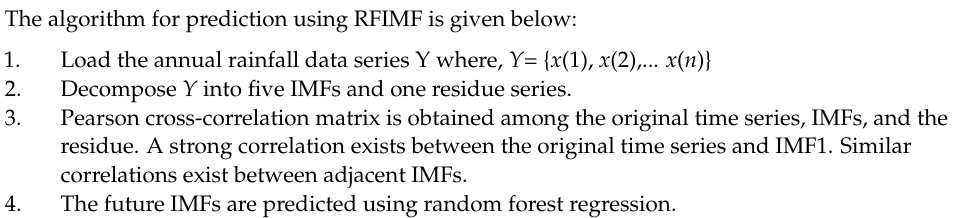
Figure 1. Flowchart for empirical mode decomposition. Algorithm 3: RF–IMF prediction